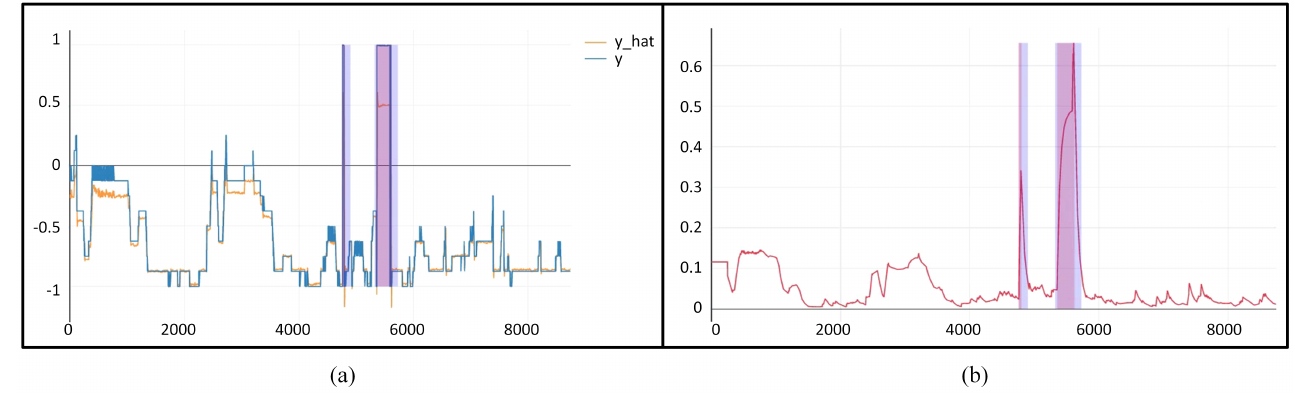
Figure 5. Results ( a ) the original data and reconstructed sequences; ( b ) the smoothed result of the difference